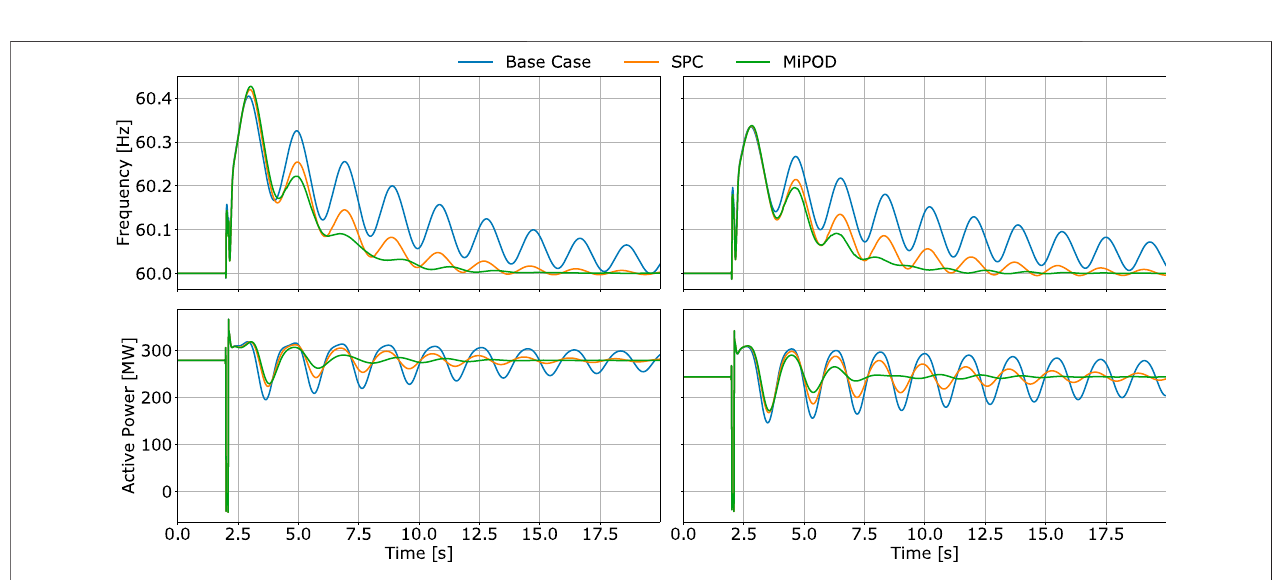
FIGURE 15 | Frequency and active power fl ow at B08 after a symmetrical fault at B07 for 2 random operating points.